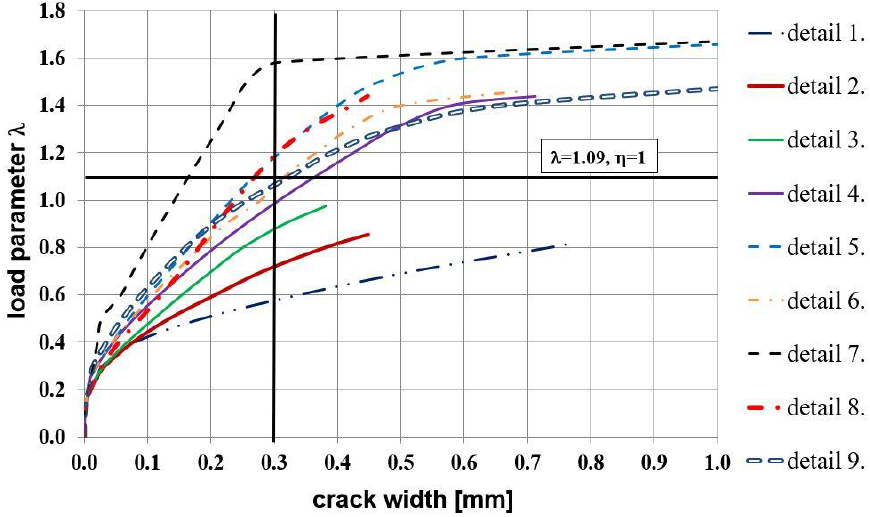
Figure 26. Crack width vs. loading parameter in the plane stress state. Table 8. Efficiency factors for all reinforcement details obtained using all methods (maximal values in bold). Detail